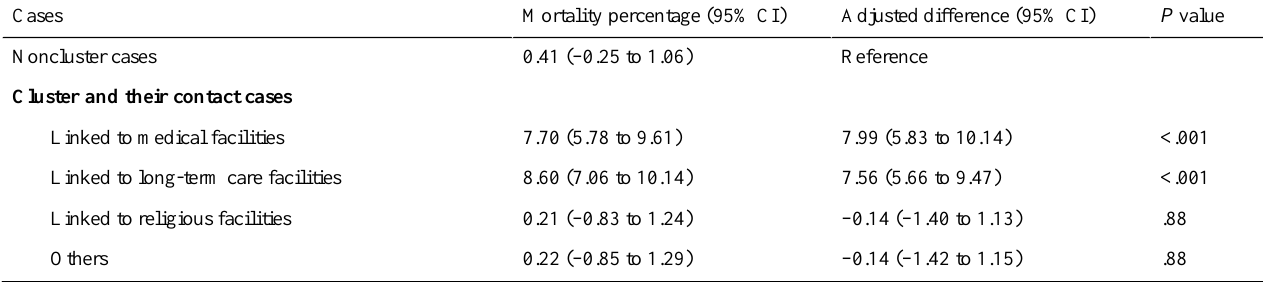
Table 2. Mortality rate for COVID-19 according to the infection route in South Korea (n=2134).